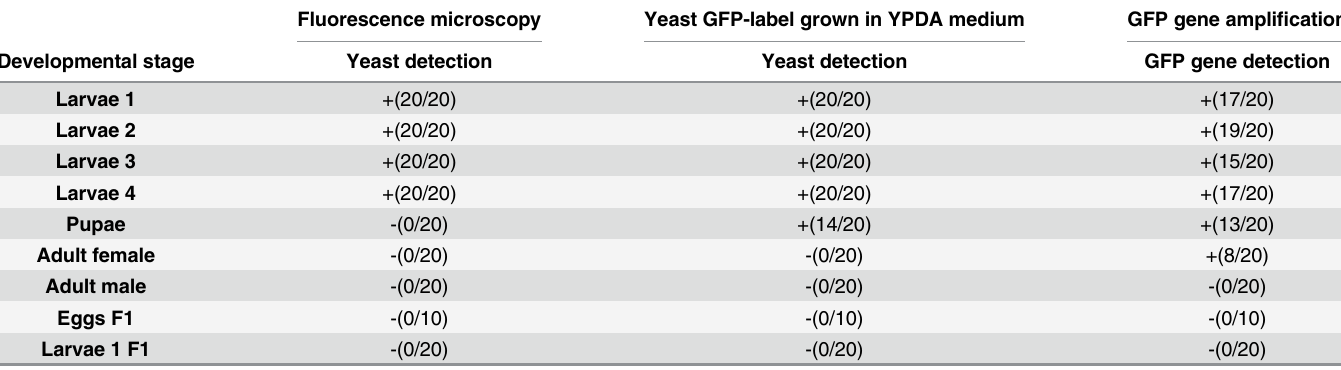
Table 1. S . cerevisiae GFP-label detection in different developmental stages of Cx . pipiens by the identification of the presence of fluorescent sig- nal observed under fluorescence microscopy, grown in YPDA culture medium and the amplification of the GFP gene by